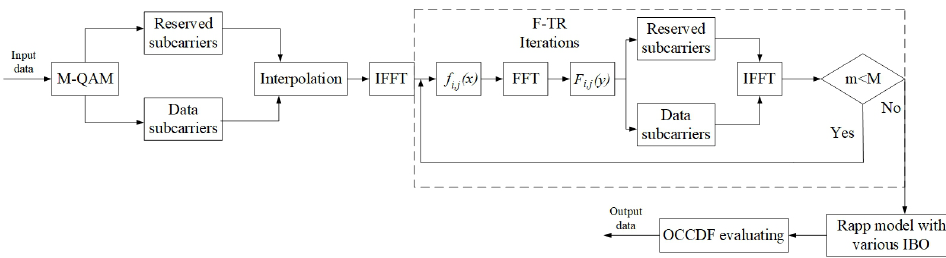
Figure 2. The structure of F-TR